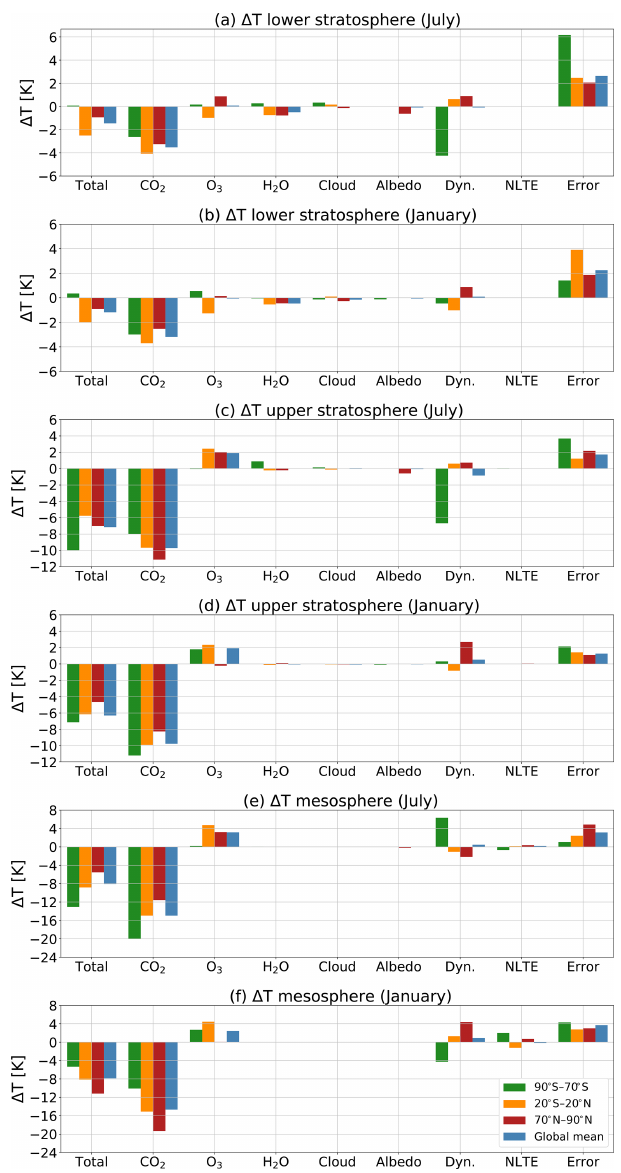
Figure 11. The mean temperature responses to the changes in CO 2 and various feedback processes in the lower stratosphere from the tropopause height up to 24hPa (a, b) , the upper stratosphere from 24 to 1hPa (c, d) and in the mesosphere from 1 to 0.01hPa (e, f) in July (a, c, e) and January (b, d, f) in the polar regions (90–70 ◦ S and 70–90 ◦ N) and the tropics (20 ◦ S–20 ◦ N) and the global mean for the S3 experiment (double CO 2 and changed SSTs). Note that the range of values on the y axis is not the same for the different